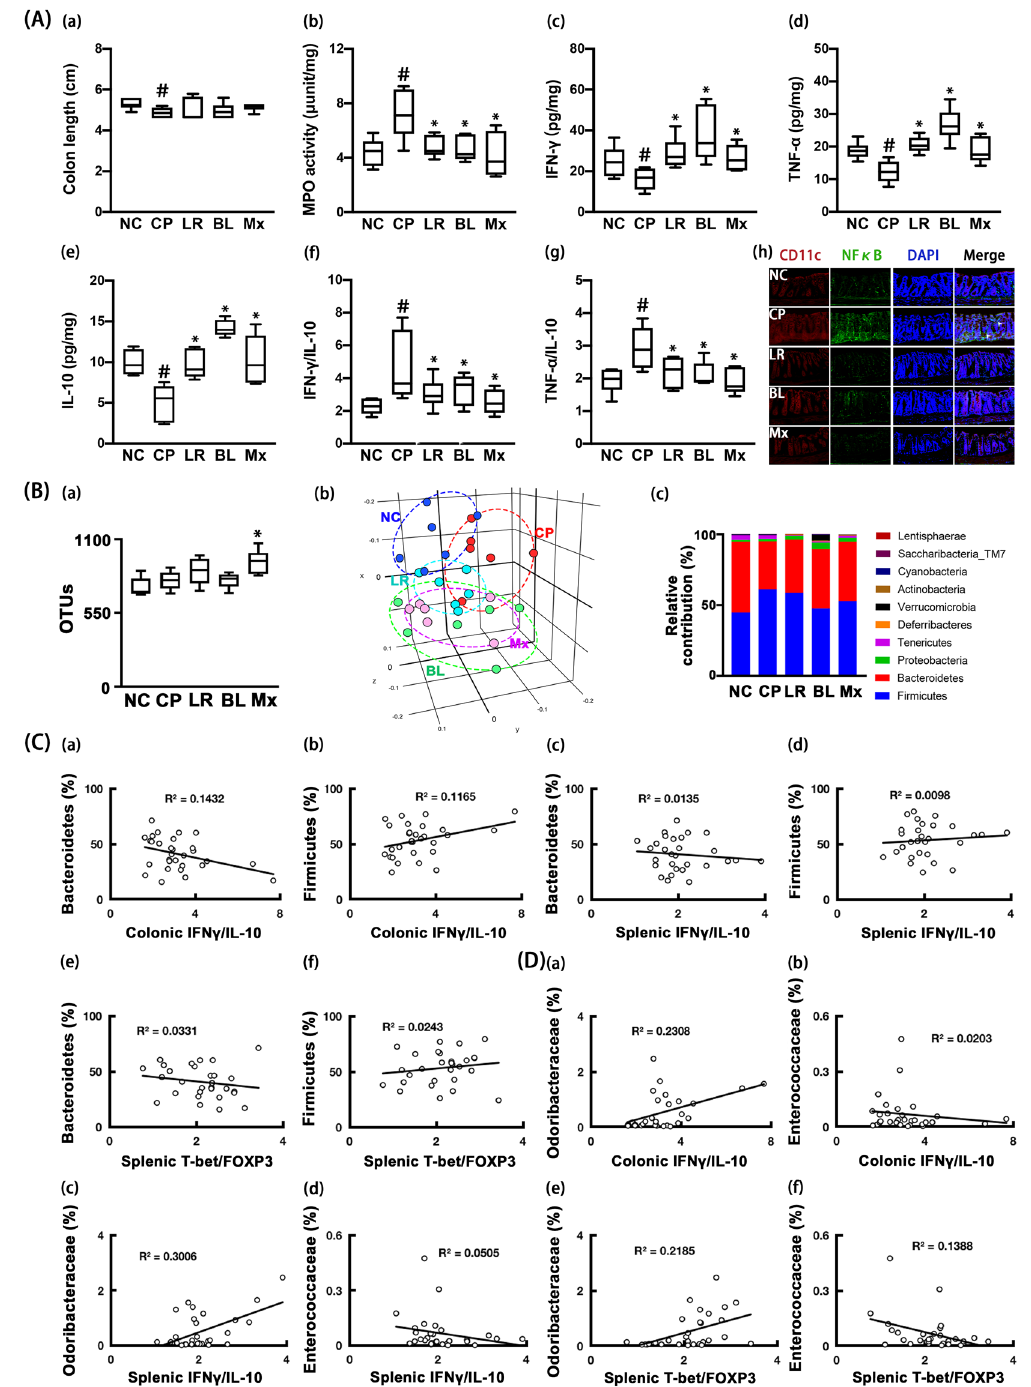
Figure 6. Effects of NK210 and NK219 on cyclophosphamide-induced gut inflammation and microbiota alteration in mice. ( A ) Effects on colitis: colon length (a), myeloperoxidase (MPO) activity (b), IFN-γ (c), TNF-α (d), IL-10 expression (e), IFN-γ to IL-10 expression ratio (f), TNF-α to IL-10 expression ratio (g), and NF-κB + / CD11c + cell population in the colon (h). ( B ) Effects on the gut microbiota composition: (a) α-diversity (OUT richness, a), (b) β-diversity (PCoA plot based on Jensen-Shannon analysis), and (c) gut microbiota composition at the phylum level. The correlation between gut microbiota and IFN-γ to IL-10 or Tbet to Foxp3 expression ratio at the phylum ( C ) and family levels ( D ). Test agents (CP, cyclophosphamide alone; LR, 1 × 10 9 CFU/mouse/ day of NK210; BL, 1 × 10 9 CFU/mouse/day of NK219; Mx, 1 × 10 9 CFU/mouse/day of LR and BL [4:1] mix) were orally gavaged daily for 5 days after intraperitoneal injection of cyclophosphamide. Normal control mice (NC) were treated with vehicle (saline) instead of test agents. Data values indicate mean ± SD (n = 8). # p < 0.05 versus NC group. * p < 0.05 versus CP group treated with cyclophosphamide